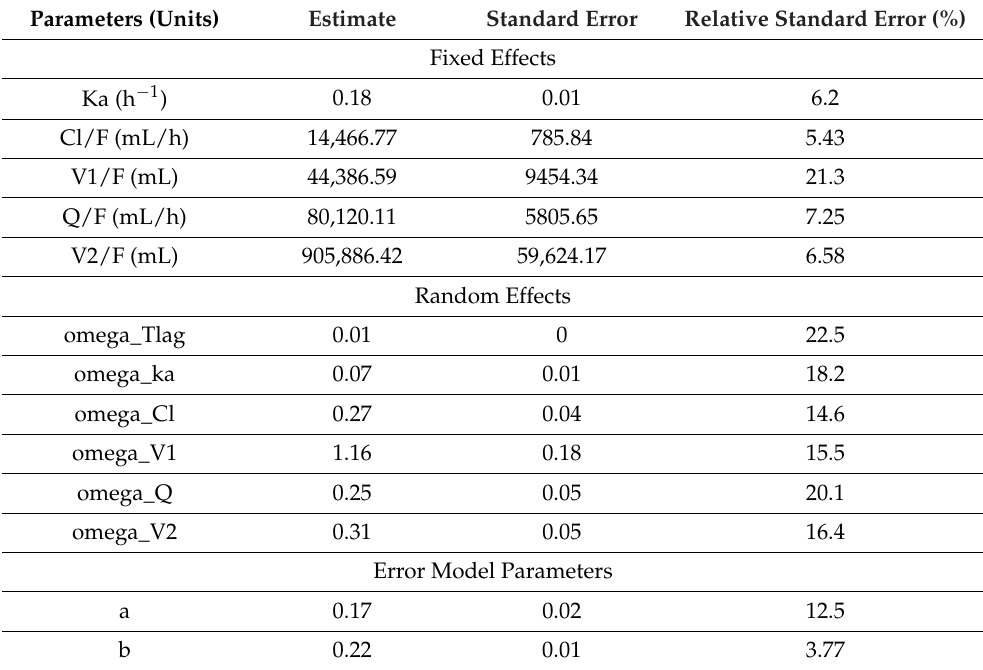
Table 2. Parameter estimates of the final population pharmacokinetic model of donepezil.